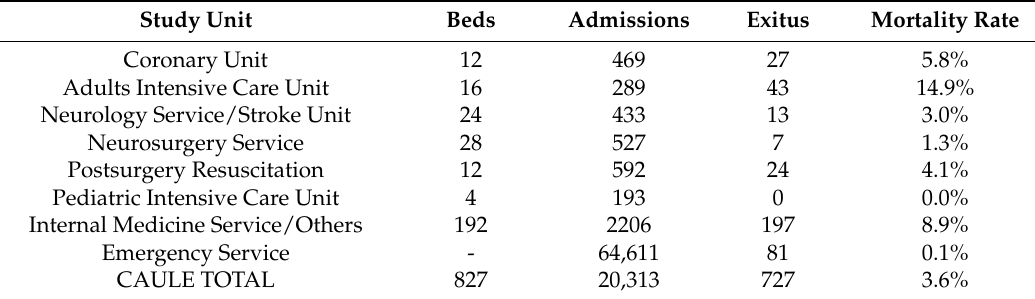
Table 2. Activity indicators of units generating potential donors